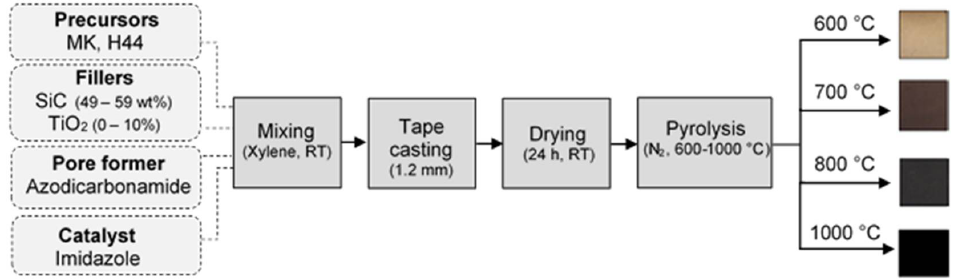
Figure 1. Flowchart of the membranes’ processing route.